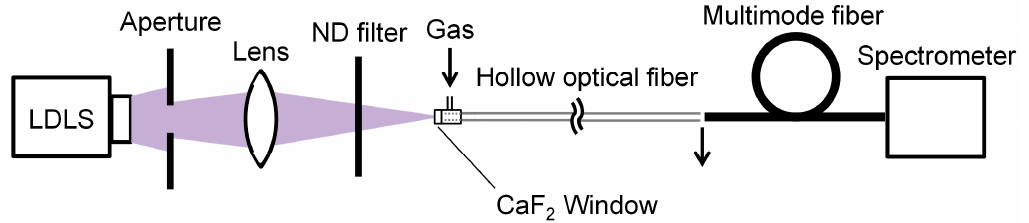
Figure 1. Experimental setup for UV-absorption spectroscopy of gases.